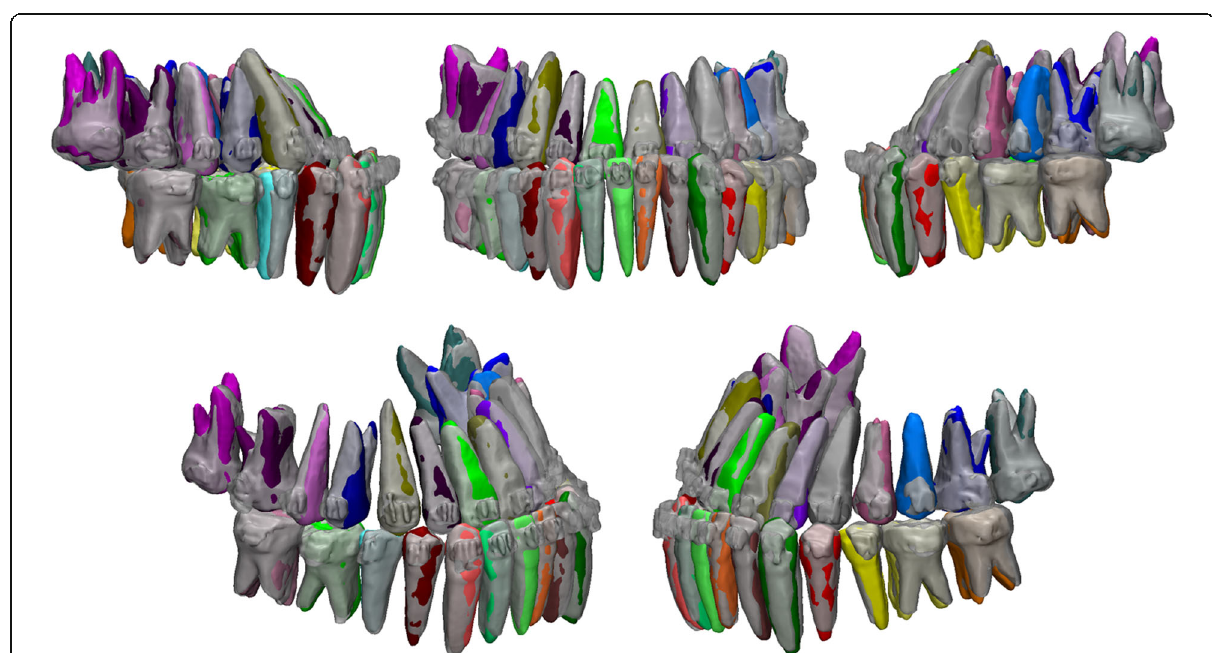
Fig. 6 Qualitative comparison of the ERP setup (multicolored teeth) and the reset appointment CBCT teeth (transparent gray) after indirect